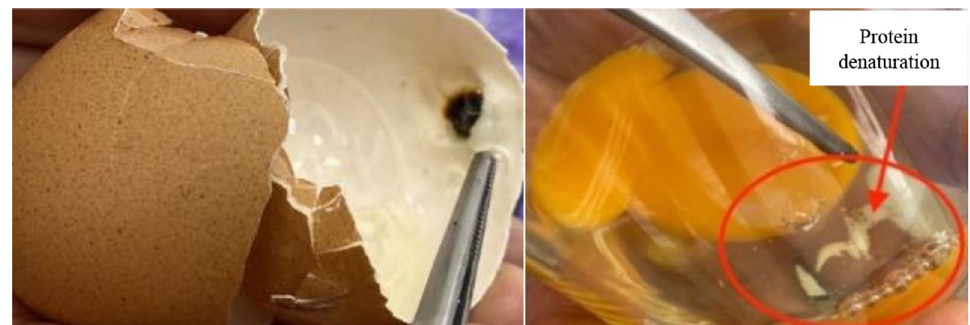
Figure 1. Burn mark on eggshell and protein denaturation in egg white.